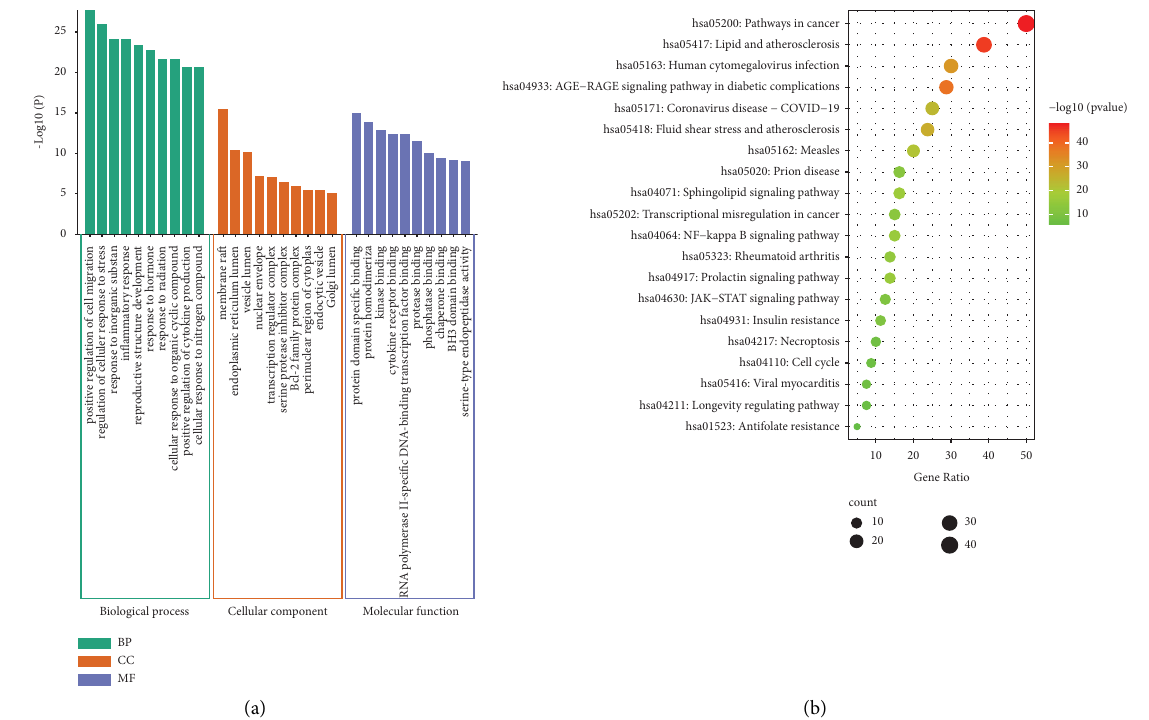
Figure 4: GO (a) and KEGG (b) enrichment analysis of Yinqiao powder in treating for